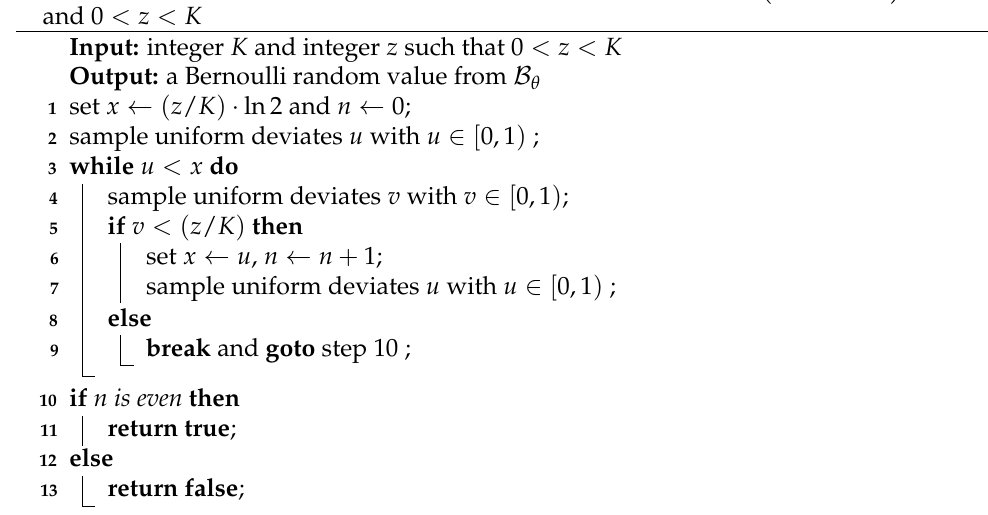
(cid:16) (cid:1) 2 (cid:17) − ln 2 (cid:0) z K